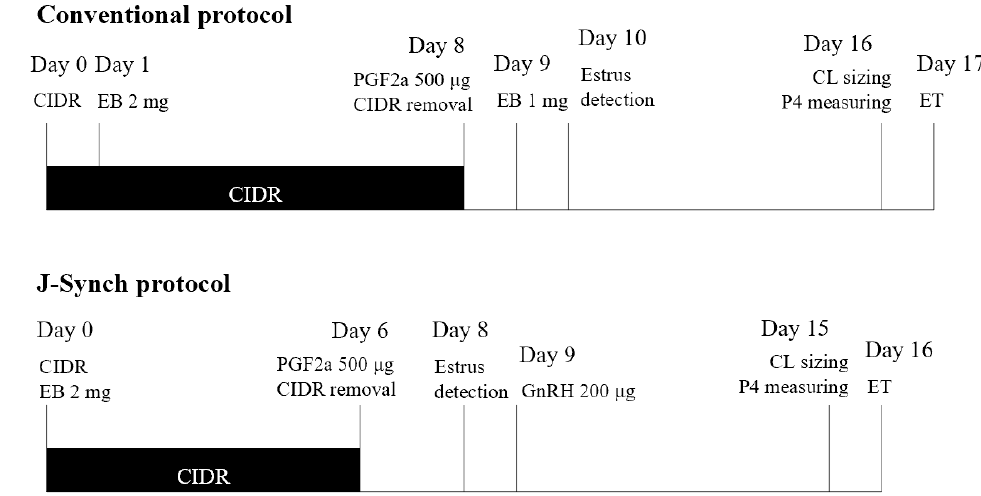
Figure 1. Diagram of two estrus synchronization protocols for embryo transfer (ET) and recipient evaluation with corpus luteum (CL) sizing and progesterone (P4) measuring; CIDR = insertion of an intravaginal device with 1.38 g of progesterone, EB = injection of estradiol benzoate, PGF2 α = injection of prostaglandin F2 α , GnRH = injection of gonadotropin-releasing hormone.